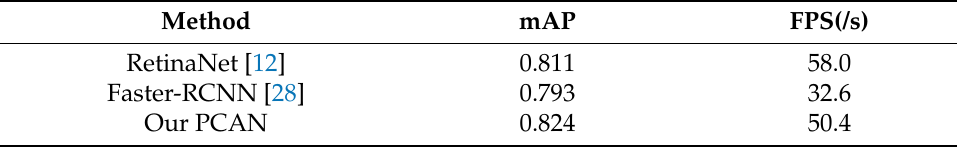
Table 4. Experiments on ship dataset